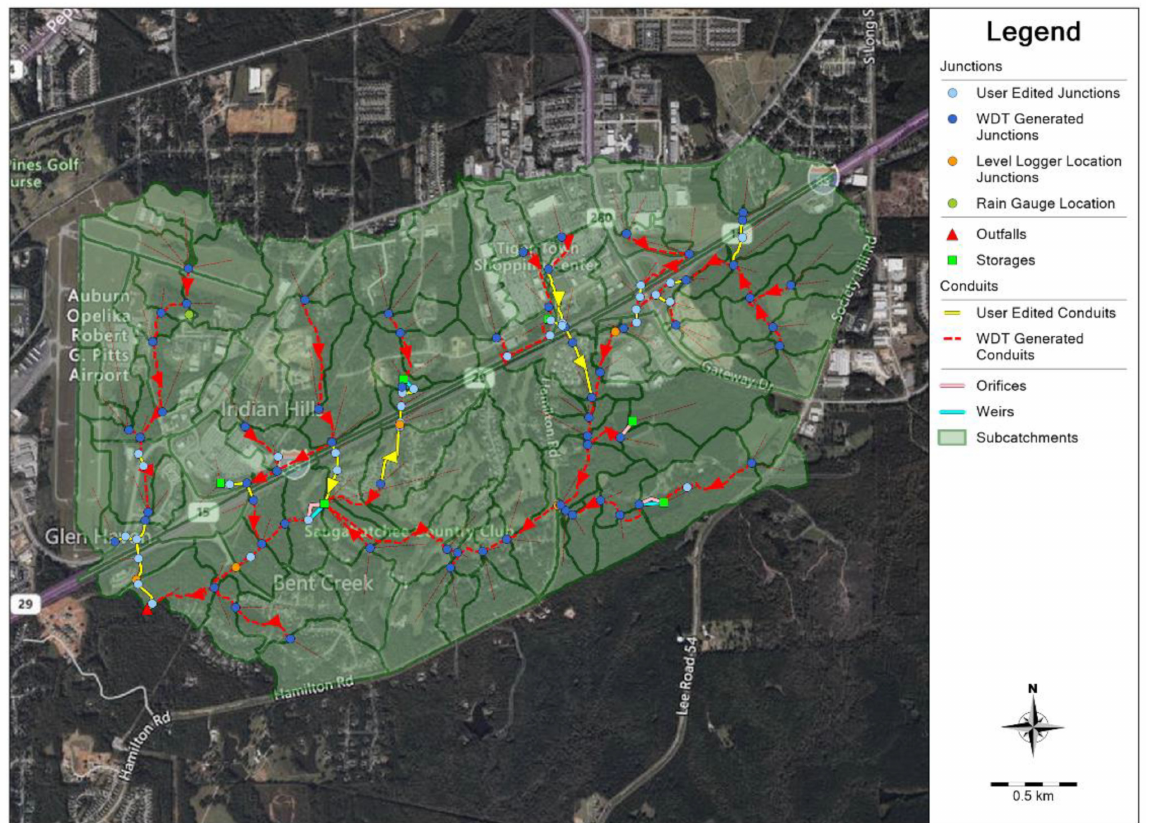
Figure 4. Sub-catchments within Moore’s Mill Creek with the location of the conduits, junctions and the sensors deployed in the field